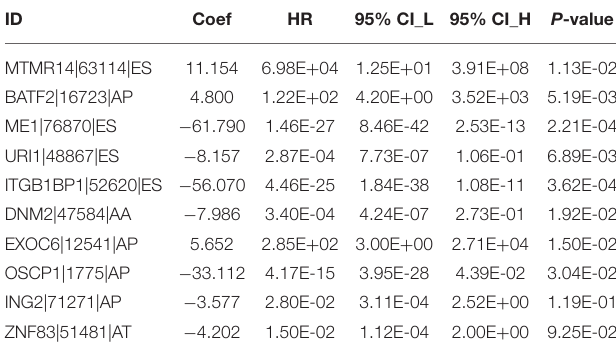
TABLE 1 | Prognostic signature based on